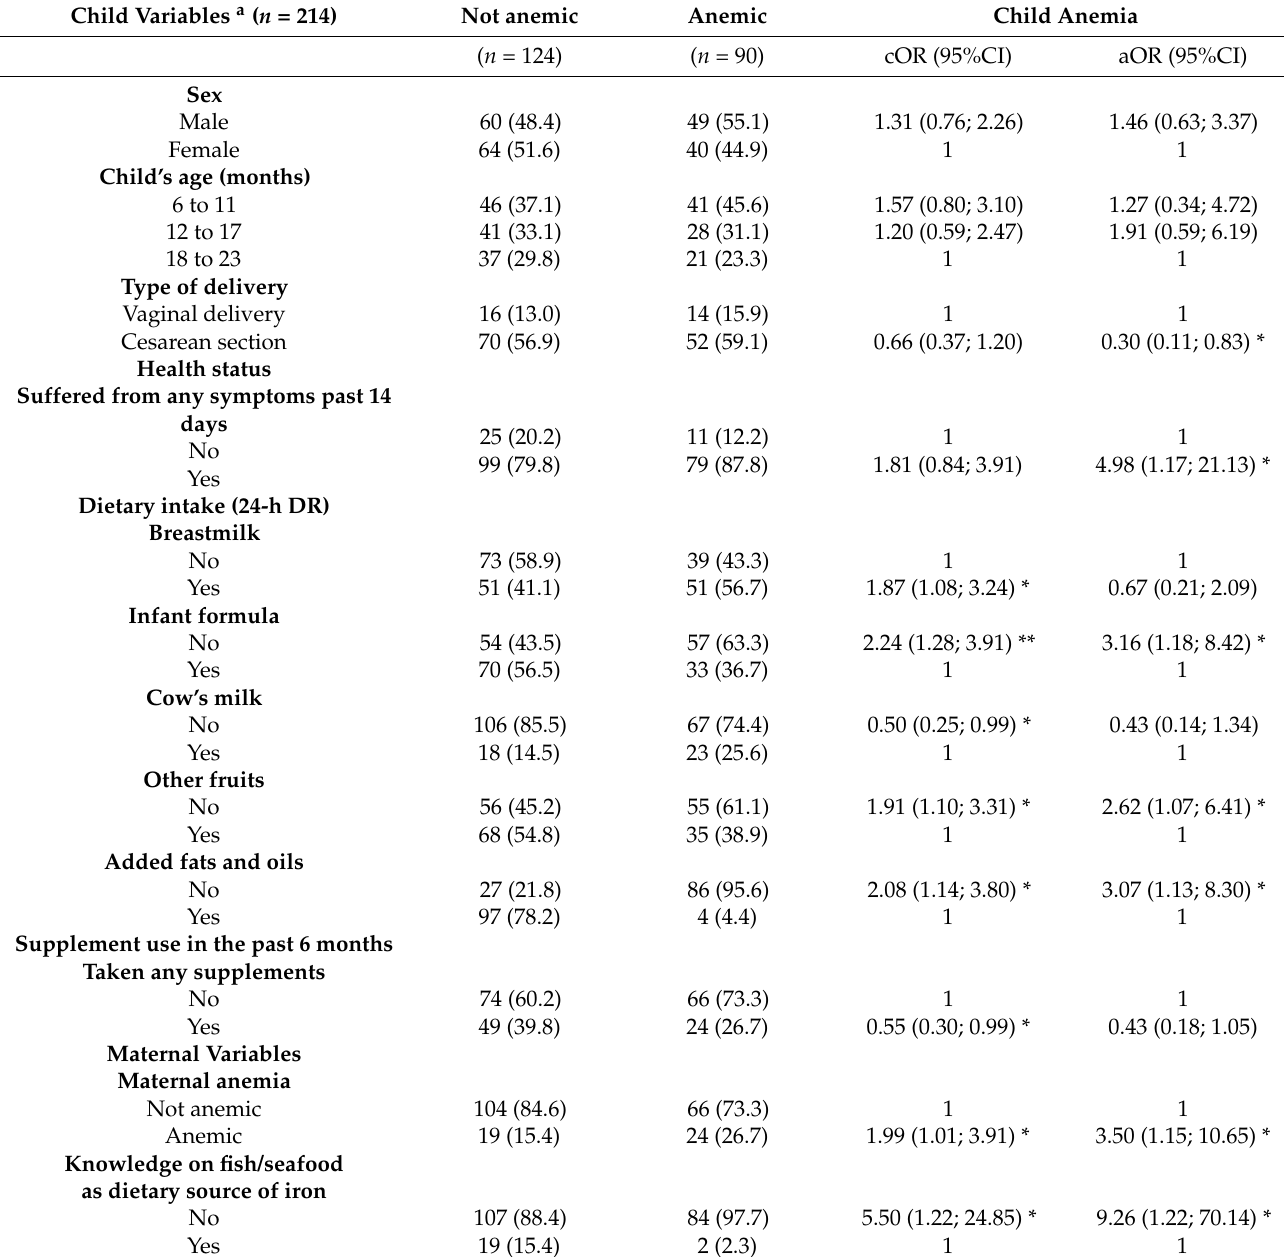
Table 6. Determinants of anemia of Syrian refugee children aged 6 to 23